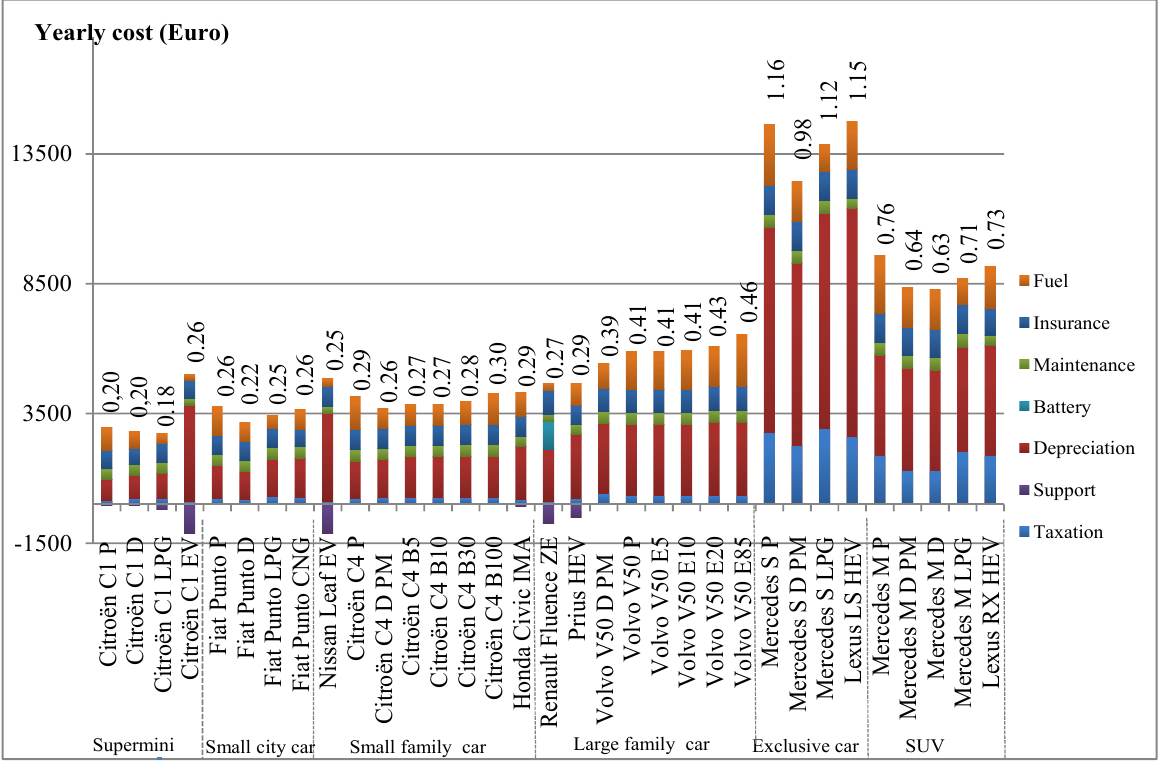
Figure 2. Life cycle cost in current vehicle taxation